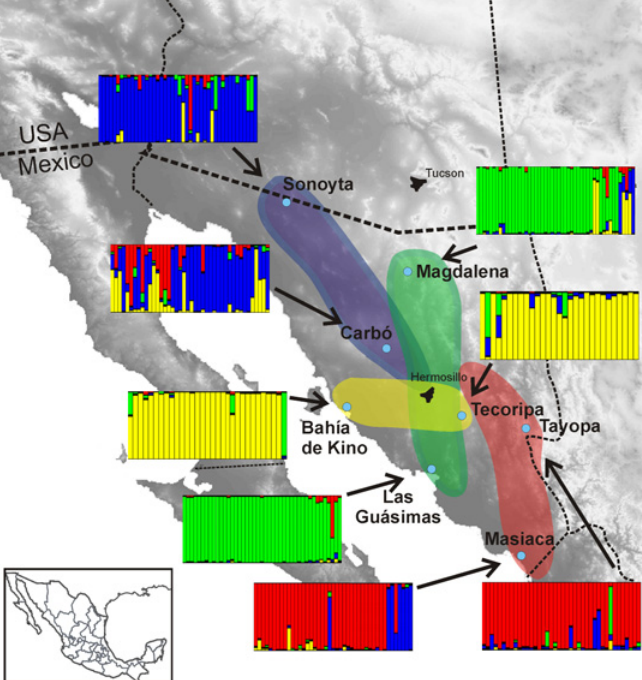
Fig 3. Resultant groups from STRUCTURE. Note the multiple SE-NW grouping, and the marked E-W group in central Sonora.